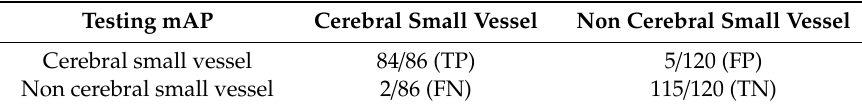
Table 1. Training mAP of our proposed model. Table 2. Testing mAP of our proposed model.